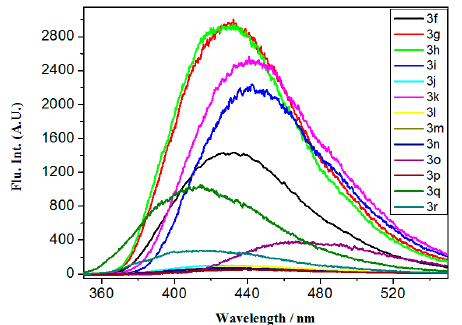
Figure 5. The emission spectra of compounds 3 ( f – r ).